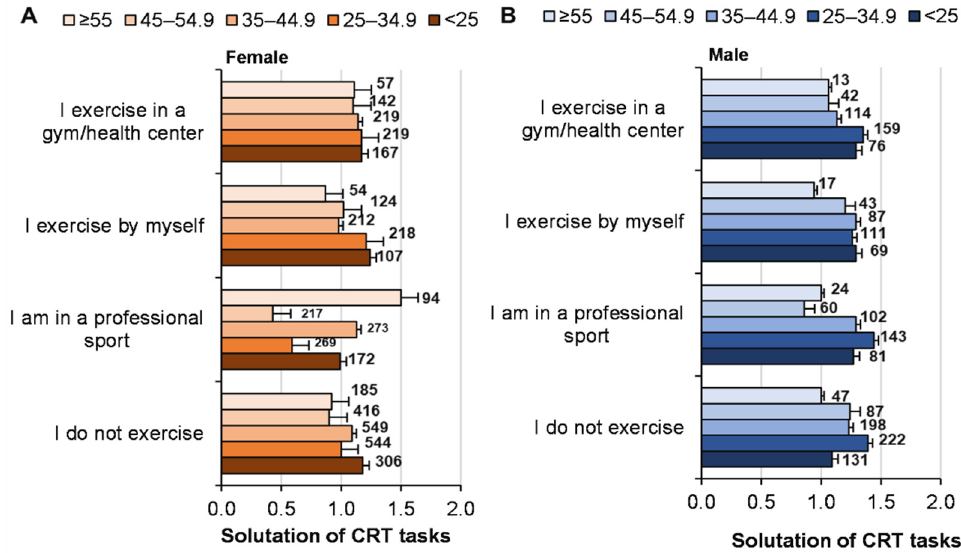
Figure 6. Solving CRT tasks and specific sporting activities depending on age and gender. At the top of the column is the number of participants. (( A )—women solutions of CRT and specific sporting activities depending on age; ( B )—men solutions of CRT and specific sporting activities depending on age).